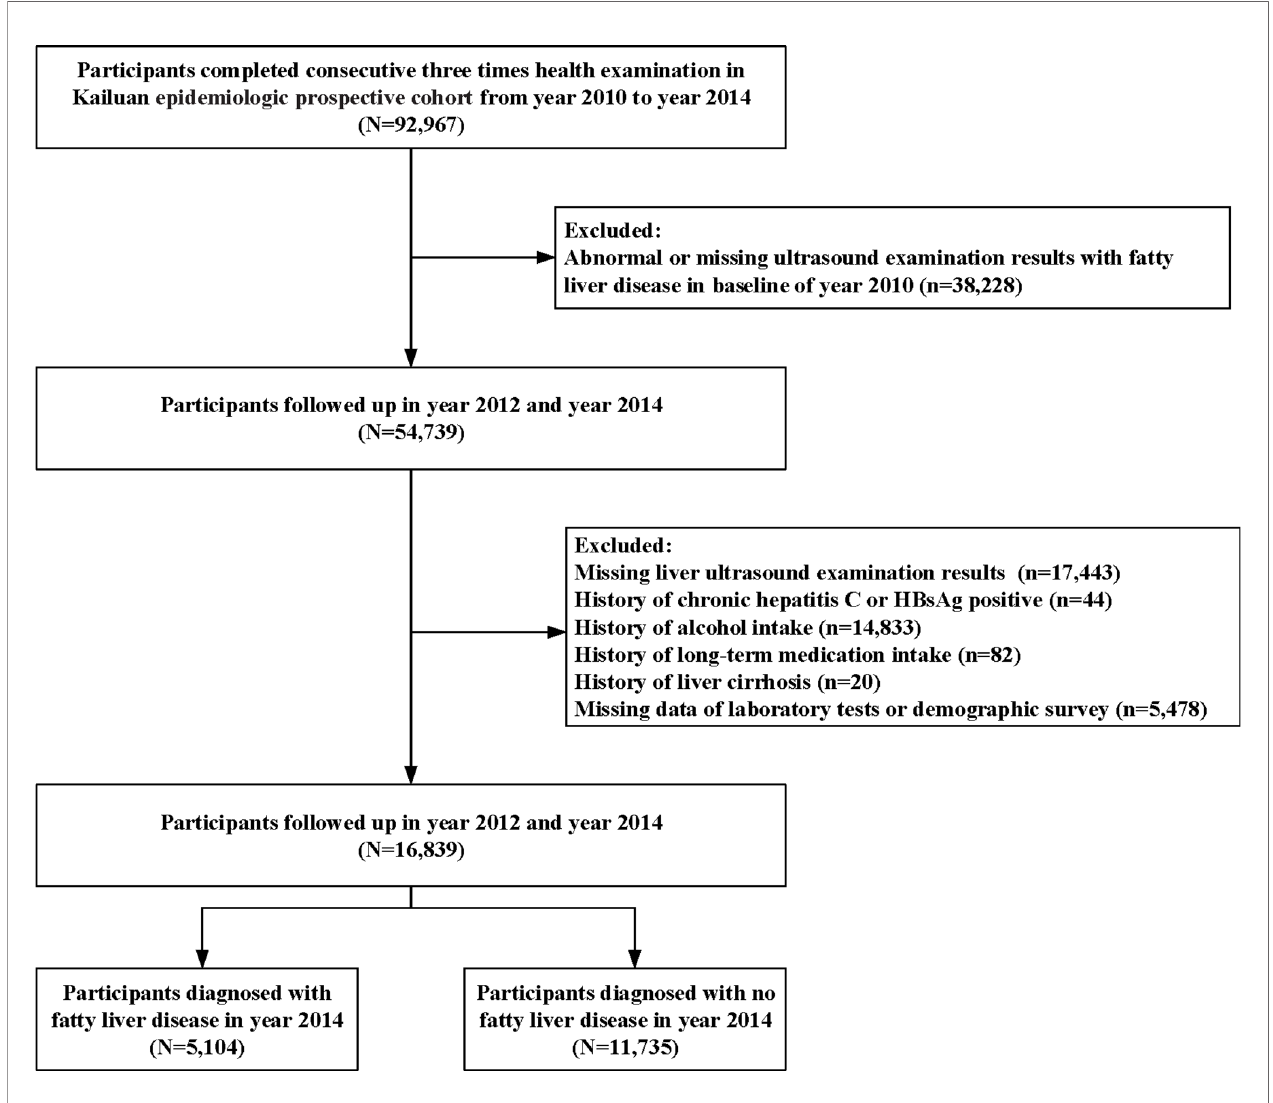
FIGURE 1 | The fl ow chart of the enrolled